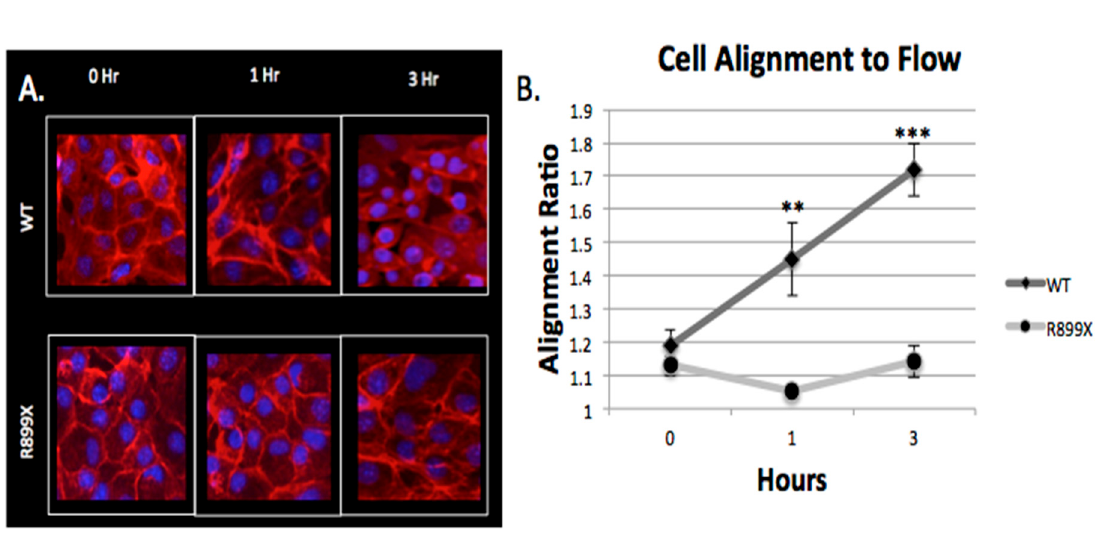
Figure 6. Bmpr2 R899X endothelial cells do not align in the direction of flow. ( A ) Morphological differences were seen in the WT cells as the amount of perfusion time increases, whereas the Bmpr2 R899X cells did not show evidence of elongation. Images were taken at 20 × . ( B ) Without perfusion, both Bmpr2 R899X and WT endothelial cells showed no difference in cell morphology and alignment ratio ( p > 0.05). After 1 h of perfusion, the WT cells started to align, but the Bmpr2 R899X cells showed no evidence of aligning in the direction of flow ( p < 1.0 × 10 − 4 ). The WT cells continued to elongate and increase their alignment ratio while the Bmpr2 R899X cells maintained a nearly constant alignment